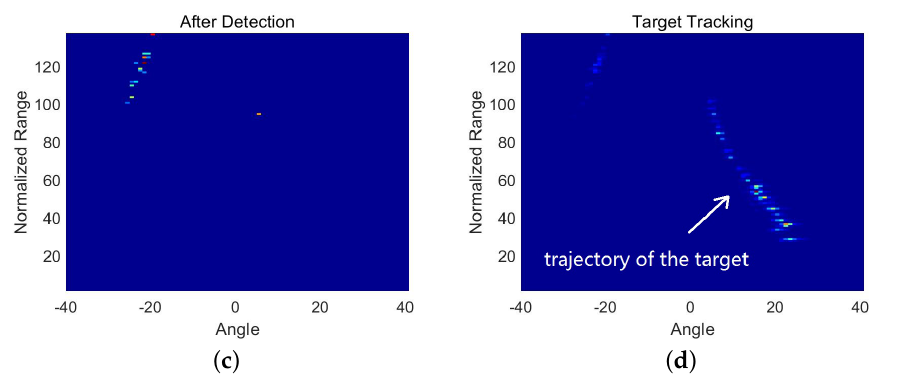
Figure 2. Detection results of a hollow ball. ( a ) is one frame of data in beamspace before detection; ( b ) is the sparse component of the corresponding frame data; ( c ) is the detection result of corresponding frame data; ( d ) is the trajectory of the target.